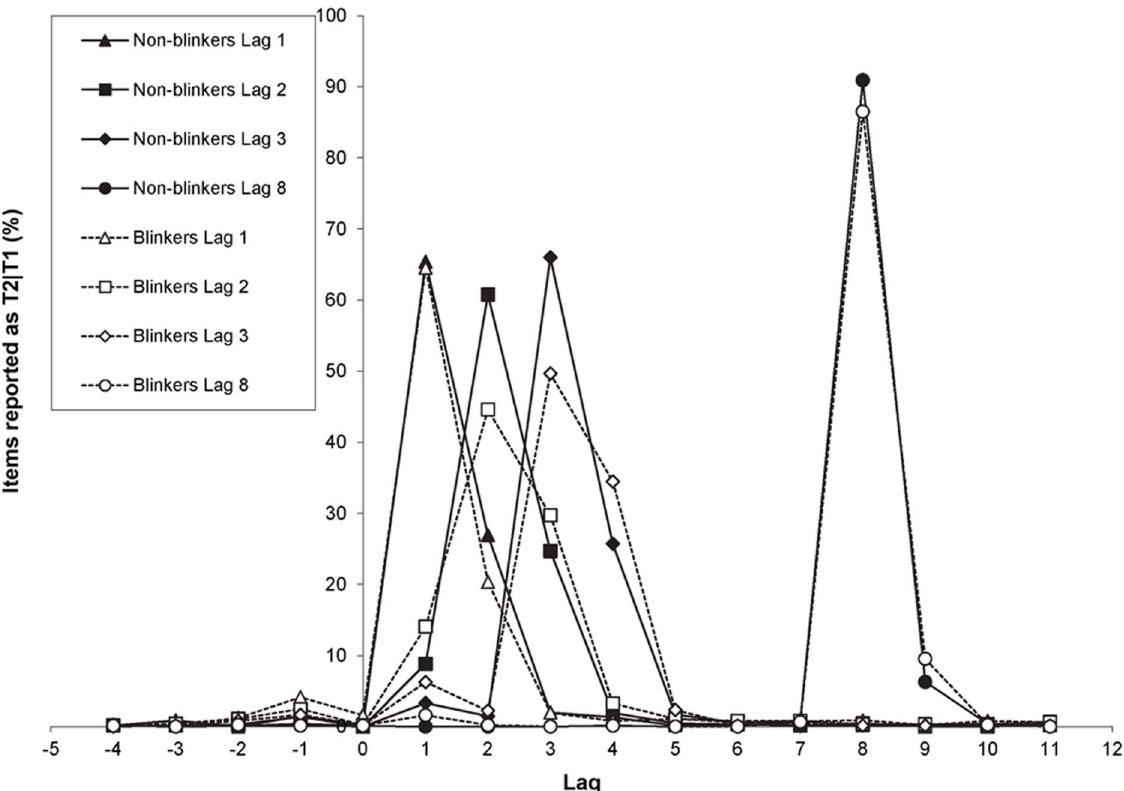
Figure 4. Distribution of T2|T1 reports in Experiment 1b. The percentage of letters at a particular position in the RSVP stream that were reported as T2 given correct report of T1 as a function of lag, for blinkers and non-blinkers.